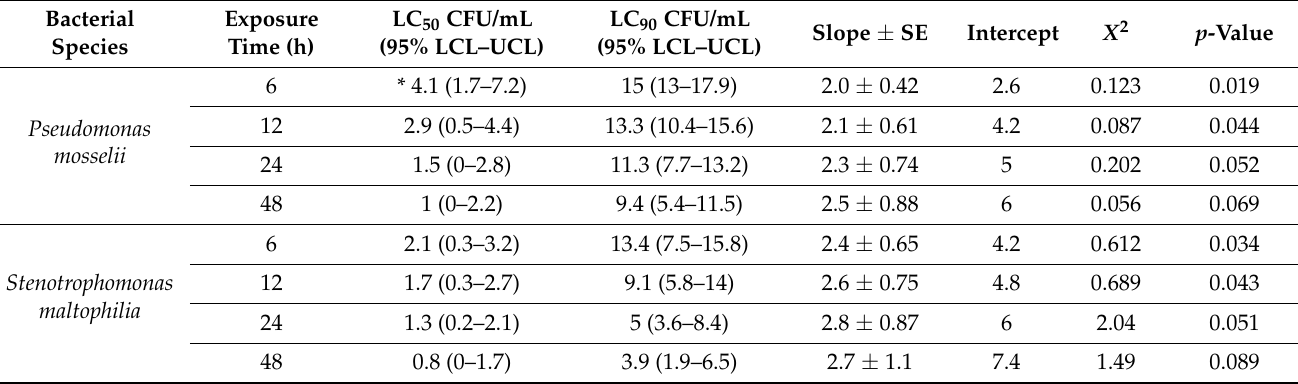
Table 6. Lethal concentrations of Pseudomonas mosselii and Stenotrophomonas maltophilia on the pomegranate butterfly, Virachola livia , under laboratory